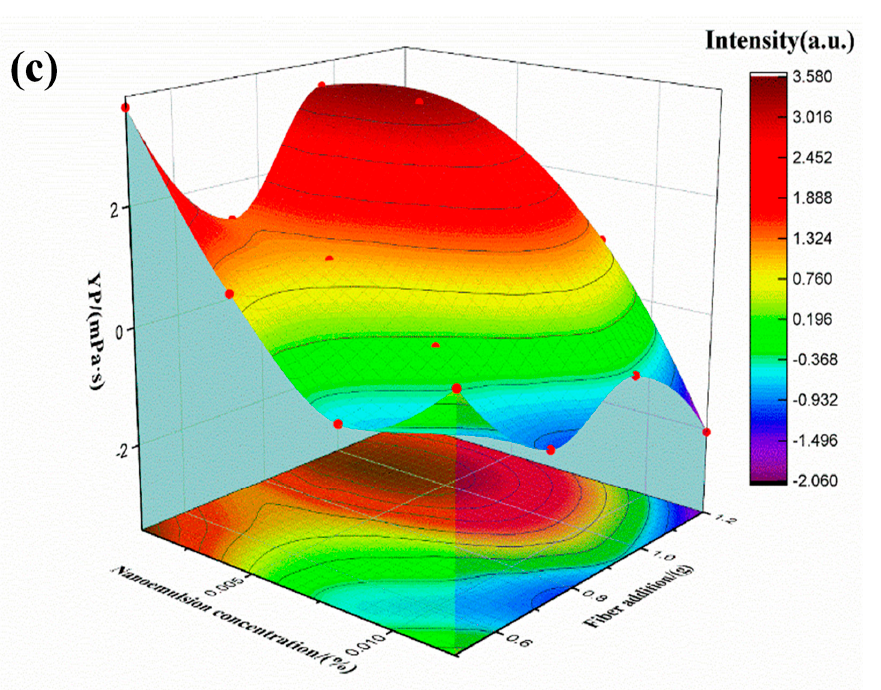
Figure 6. ( a ) Influence model of each component addition on apparent viscosity; ( b ) influence model of each component addition on plastic viscosity; ( c ) influence model of each component addition on yield value.